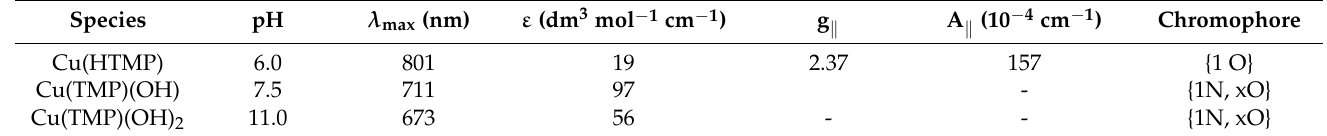
Table 2. Spectral parameters from UV-Vis and EPR studies for system Cu(II)/TMP.